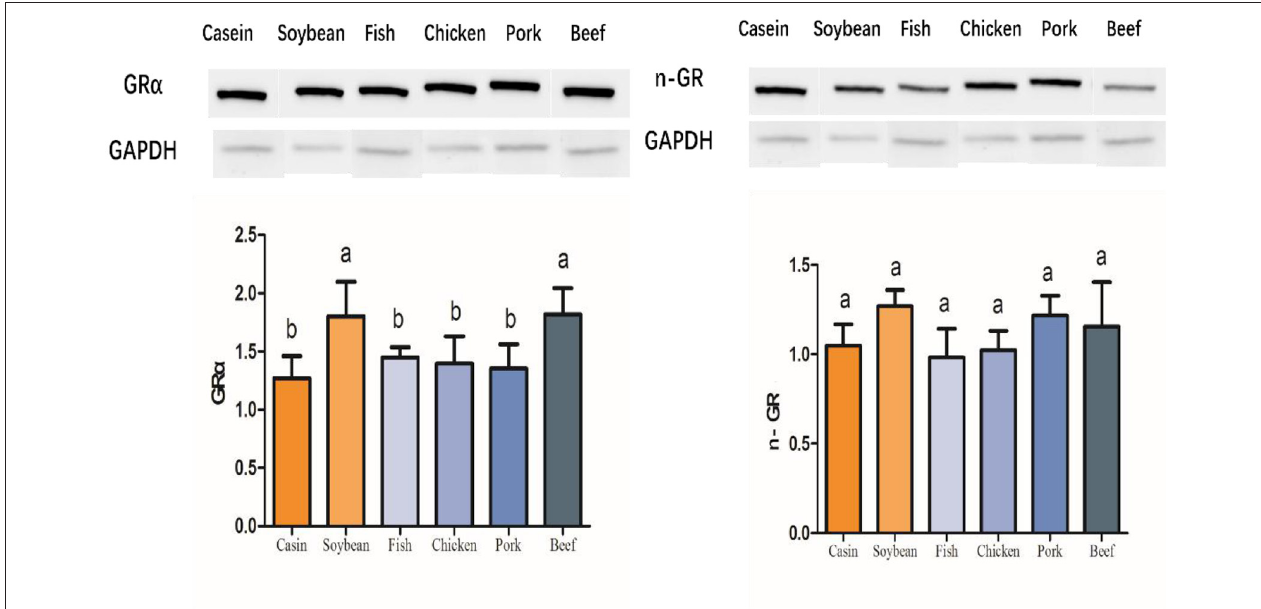
FIGURE 6 | Western blot profiles of liver GR α and n-GR in the rats fed with different dietary proteins. The columns reflect the means and standard deviations of values in gray ( n = 3). The groups were compared by one-way ANOVA followed by Duncan’s multiple range tests. Letters a–c represent significant differences among the diet groups ( p <